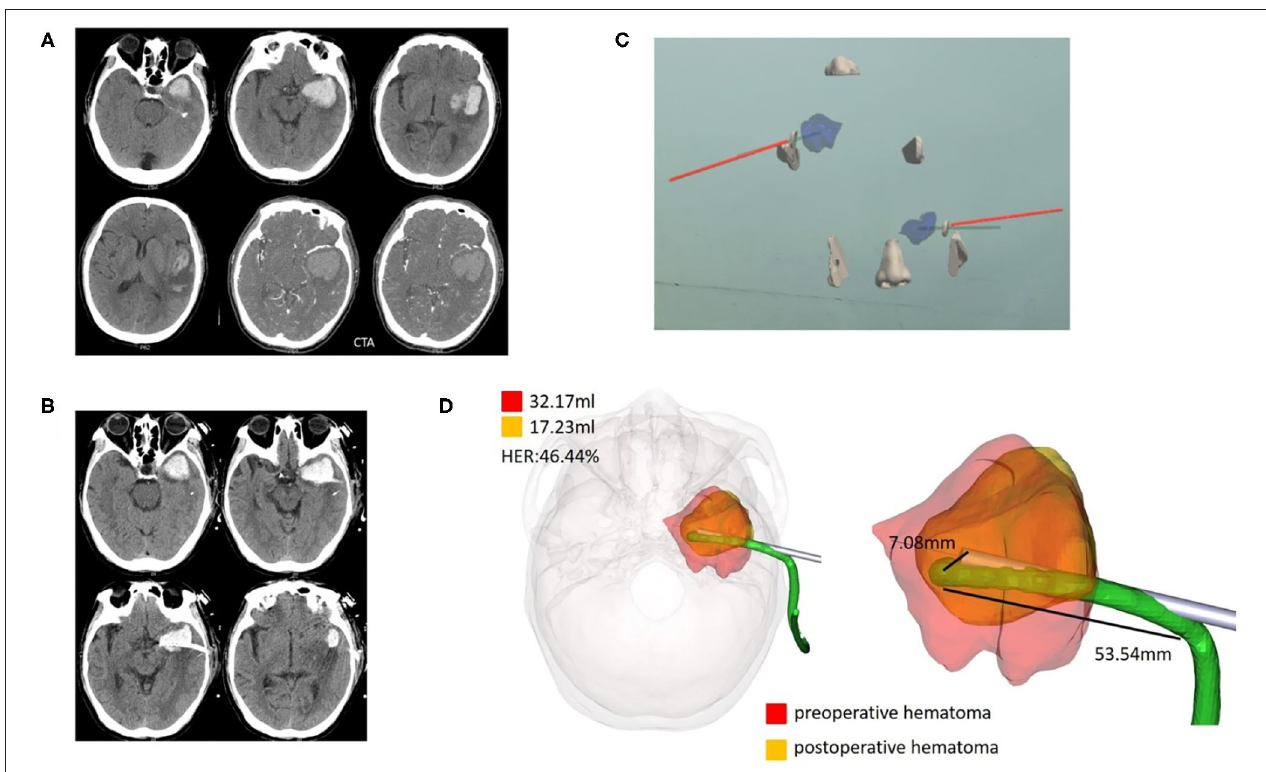
FIGURE 3 | Case 1, a 69-year-old male patient diagnosed with HICH in the left temporal lobe. (A) Preoperative CT showed a HICH in the left temporal lobe, excluding aneurysms, and arteriovenous malformation. (B) Postoperative follow-up CT. (C) Wearing HoloLens, the coronal, and horizontal planes were adjusted for puncture through the ear and nose locations. (D) For fusion of the preoperative and postoperative three-dimensional reconstruction of hematomas, the preoperative hematoma volume was 32.17 ml, the postoperative hematoma volume was 17.23 ml, and the hematoma evacuation rate was 46.44 % . The length of the intracranial drainage tube was 53.54 mm, and the deviation in the drainage tube target was 7.08 mm. HER, hematoma evacuation